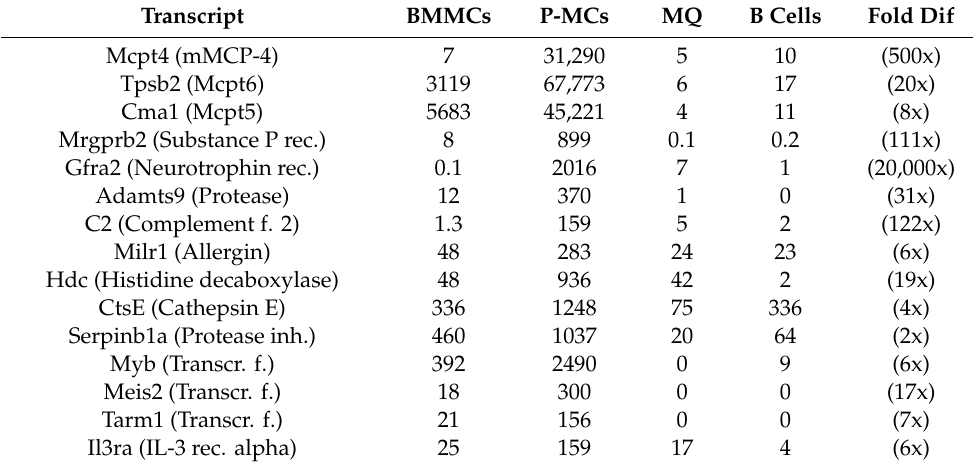
Table 1. Transcripts found at high levels in mature peritoneal MCs but at low levels in BMMCs. The table depicts the number of reads for each transcript. The right column depicts the fold di ff erence in transcript levels between P-MCs vs. BMMCs.